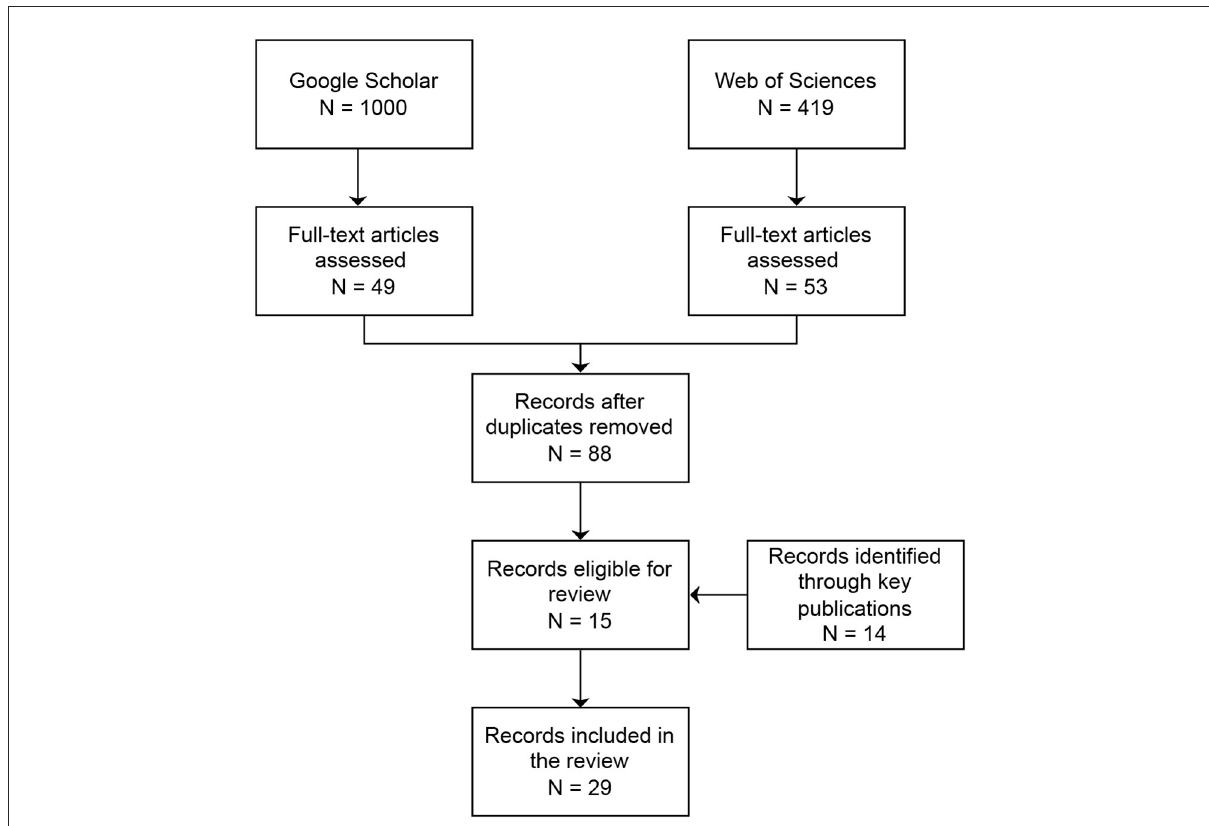
FIGURE2 Manuscript selection flow